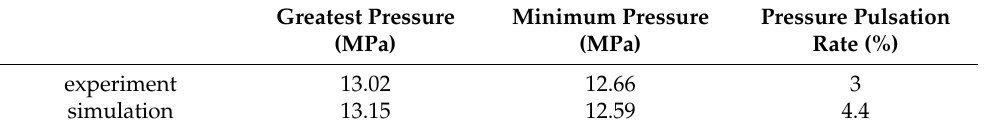
Table 9. Comparative analysis of the fluid pressure fluctuation value and pressure fluctuation